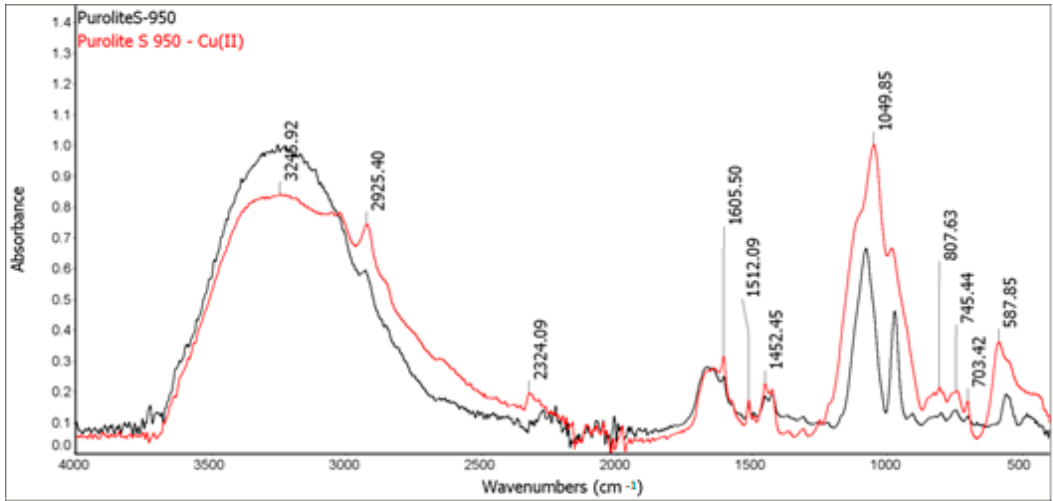
Figure 10. FTIR-ATR spectra of Purolite S 950 before and after the Cu (II) ion sorption process.